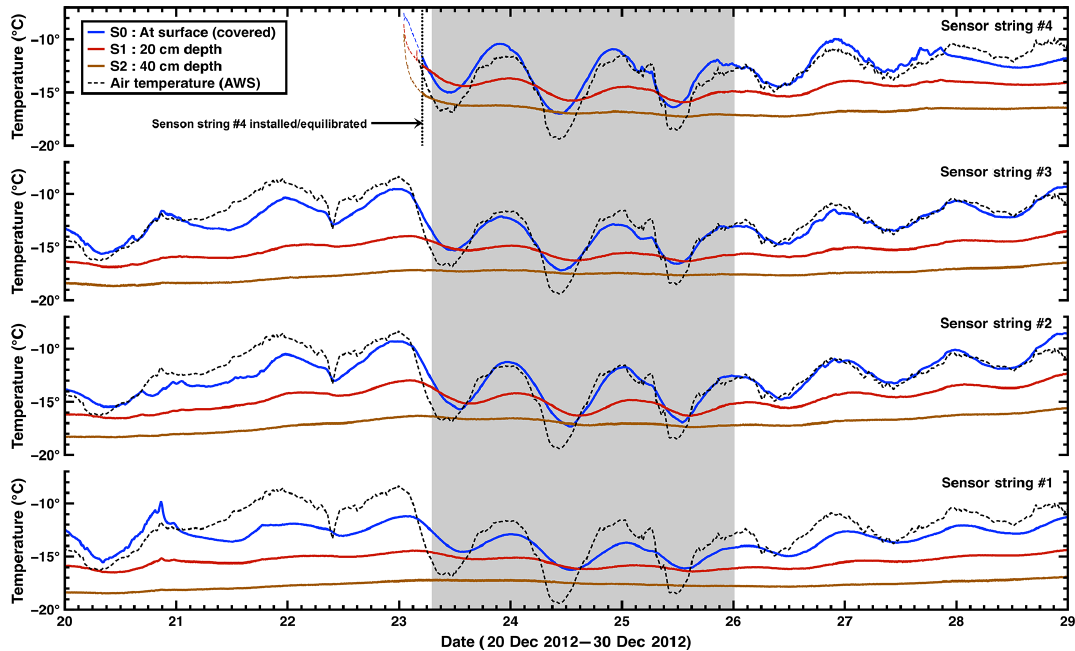
Figure 10. Temperature measurements (1min interval) in snow from the 2012–2013 season, from the uppermost three PRDs (surface down to 40cm). Data are from the four sensor stations closest to the station. The shaded area corresponds to an episode of glaze and hoar growth (see Fig. 8). Distinct near-surface temperature inversions occurred each night during this 3-day period (see Fig. 11). Sensor #4 was not installed until 22 December and therefore did not equilibrate until early on the 23 December as indicated. Air temperature is also shown as recorded by the AWS (errors listed in Table S1). The AWS temperature sensor is located ∼ 1m above the snow surface. All dates and times are GMT (WAIS local time − 12h).